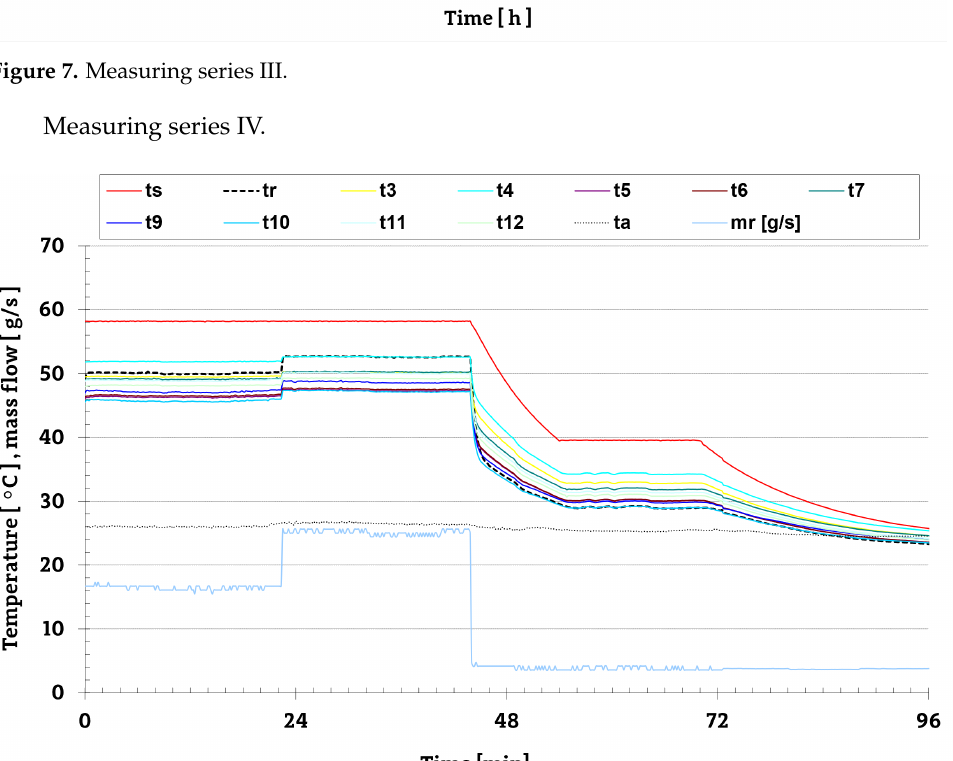
Figure 8. Measuring series IV. Measuring series